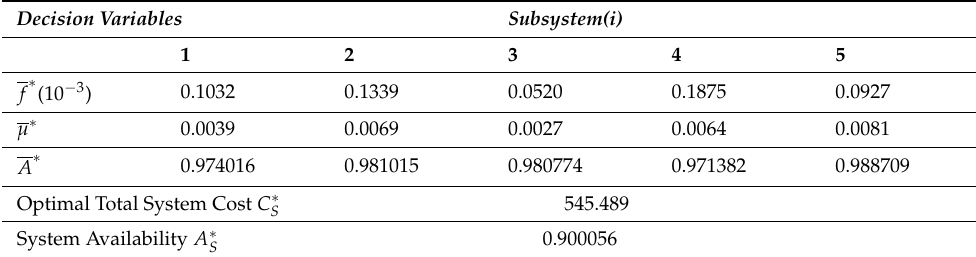
Table 4. Optimal Solutions obtained by GA for the n -stage single component series system. Decision Variables